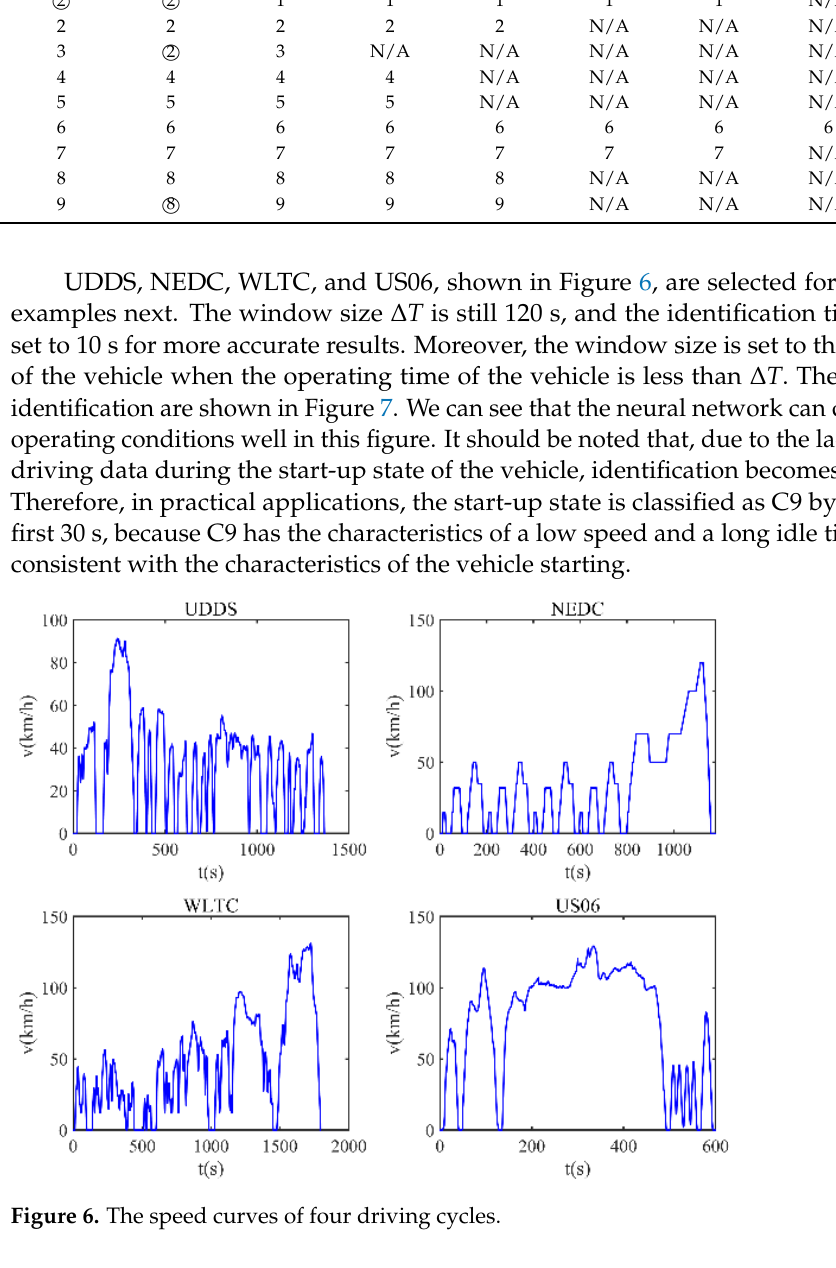
Figure 7. The identification results of four driving cycles. 5. Results a nd Comparisons To verify the effectiveness of the proposed strategy, the other three control strategies, namely, the battery-only configuration, rule-based strategy, and offline PSO-based strat- egy, are compared in this section. In this paper, UDDS, NEDC, WLTC, and US06, shown in Figure 6, are used as the test driving cycles. UDDS is a typical urban test cycle whose speed is relatively low. NEDC is composed of four small cycles of urban conditions and one cycle of suburban condi- tions. WLTC includes four categories of low-speed, medium-speed, high-speed, and ultra- high-speed conditions. US06 includes a long-term high-speed condition. The four driving cycles cover various road types, which can test the adaptability of strategies. 5.1. Results under UDDS Figure 8 shows the UC output power and the total power demanded under UDDS using the strategy proposed. Figure 9 shows the battery output power and the total power demanded under UDDS. Next, the simulation results are analyzed with Figures 8 and 9 simultaneously. From the figures, we can find that the overall trend of the UC output power is consistent with the total power. When the total power is greater than zero, the battery and UC provide energy together. When the total power is less than 0, that is, when the EV brakes, the UC absorbs most of the braking regenerative energy. Moreover, it can be seen that when P > 0, if the total power is small and changes violently, such as area ① , the amplitude of the battery output power is significantly reduced, and the waveform of the battery output